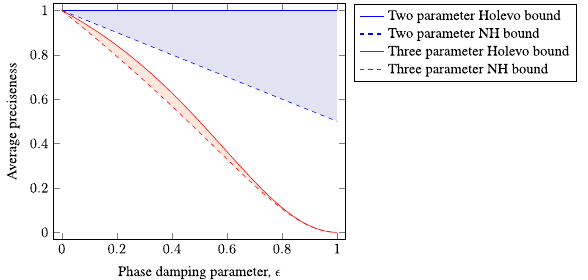
Fig. 1 Holevo and Nagaoka – Hayashi bounds for estimating multiple orthogonal rotation parameters simultaneously. For a maximally entangled two-qubit probe under the action of the phase damping channel, we plot the Holevo bounds (solid lines) and Nagaoka – Hayashi bounds (dashed lines) in terms of average preciseness for estimating two (blue) and three (red) orthogonal rotation parameters simultaneously. The Nagaoka – Hayashi bounds can be achieved by a separable measurement on a single probe, while the Holevo bound requires a collective measurement on a possibly in fi nite number of copies. The shaded area shows the gap between the two bounds. For estimating a single parameter, the Holevo and Nagaoka – Hayashi bounds coincide and are equal to the two-parameter Holevo